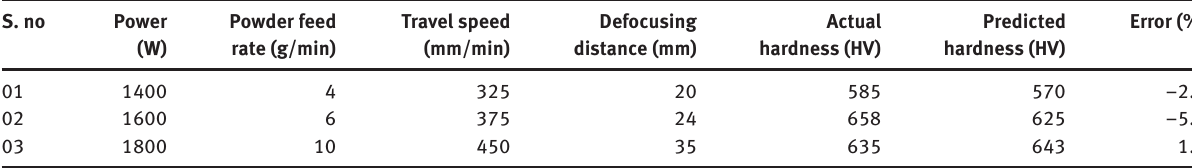
Table 8: Confirmation test results for the developed empirical relationship. S. no